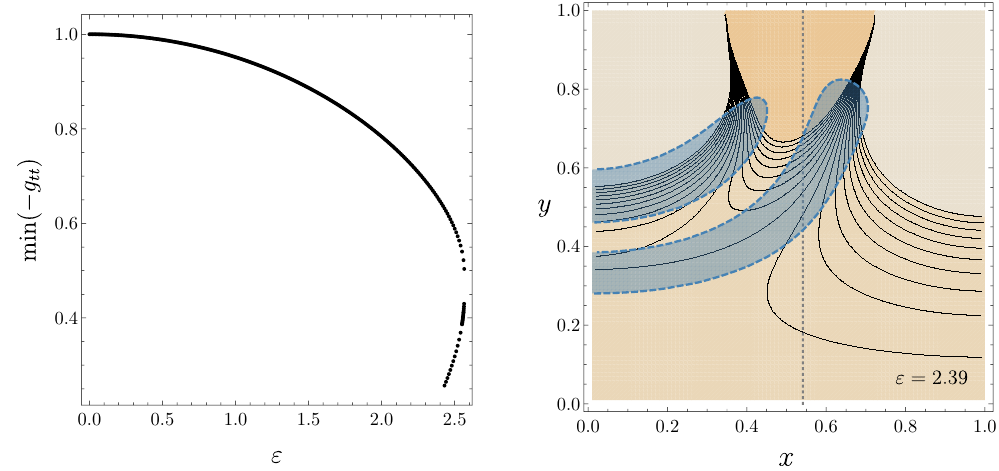
Figure 19 . Left : minima of static potential, (cid:0) g tt , for the soliton against the boundary parameter. For " < 2, there is a global minima at y = 0. For " > 2, the minima is only local, owing to the fact that there is an ergoregion attached to the boundary. For the second branch, the local minima is on the x = 0 axis, and for " & 2 : 43, the minima is no longer local. Right : contour plot for (cid:0) g tt for the second branch soliton, at " = 2 : 39. Black lines mark the contours, with the orange area around (cid:18) = (cid:25)= 4 (black dashed gridline) showing the ergoregion, and the fainter orange being the positive areas, where the function increases rapidly. Overplotted in blue are the zero contours of the Kretchmann scalar, K , whilst the shaded areas are the two minima with a steep maxima between